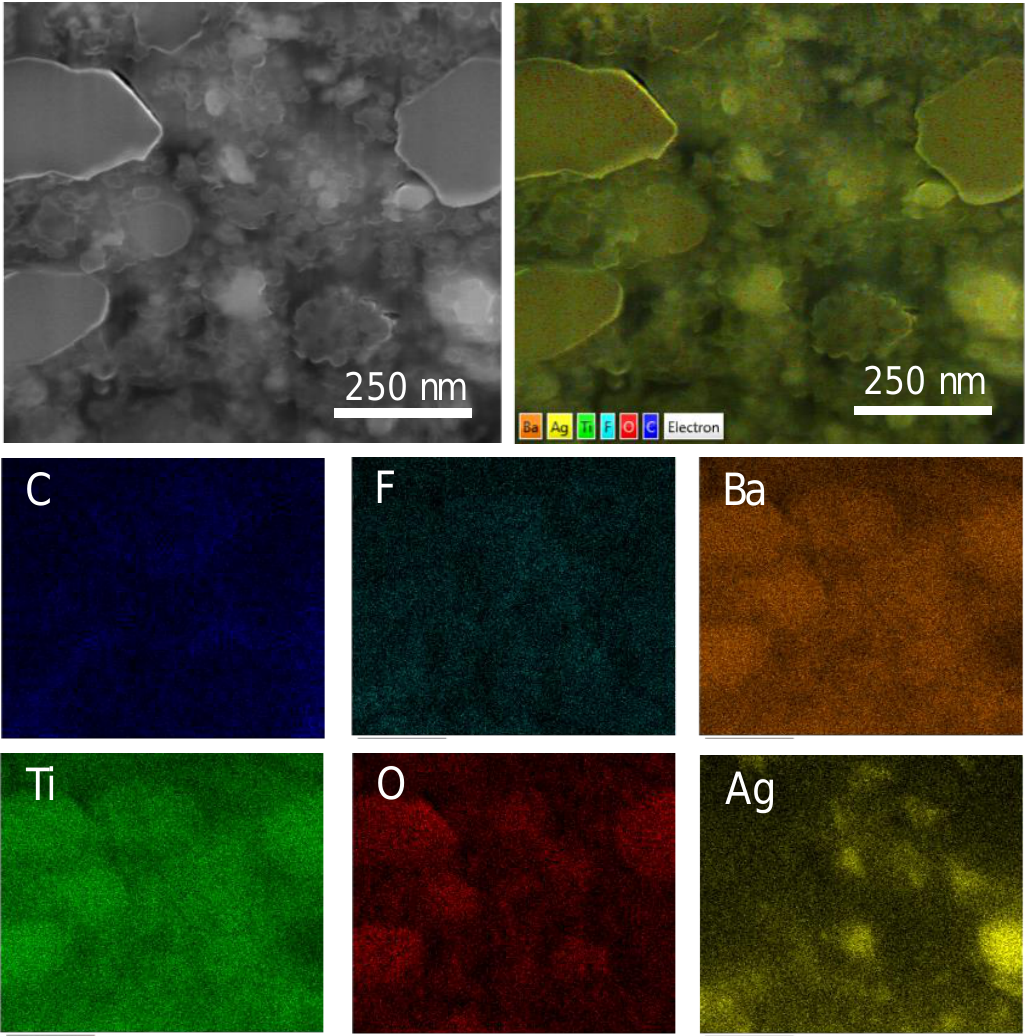
Figure 4. SEM-EDX elemental mapping of the Ag- n BT/PVDF-(0.2) μ BT composites with f Ag-nBT = 0.30.